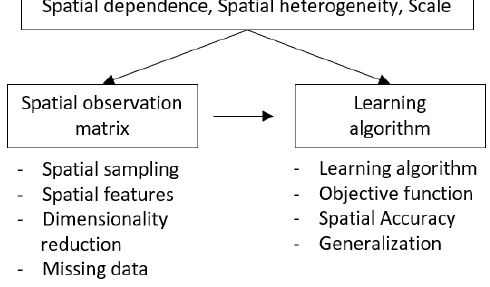
Figure 3. Machine learning of spatial